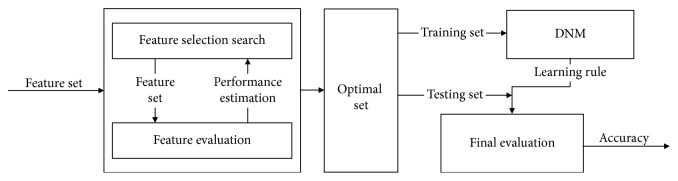
The wrapper approach to the proposed Mr2DNM.